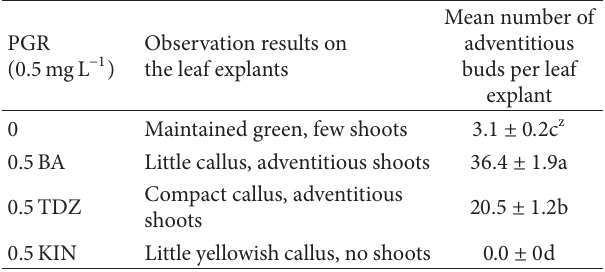
Table 1: Effects of different cytokinins on shoot morphogenesis from leaf explants of L.